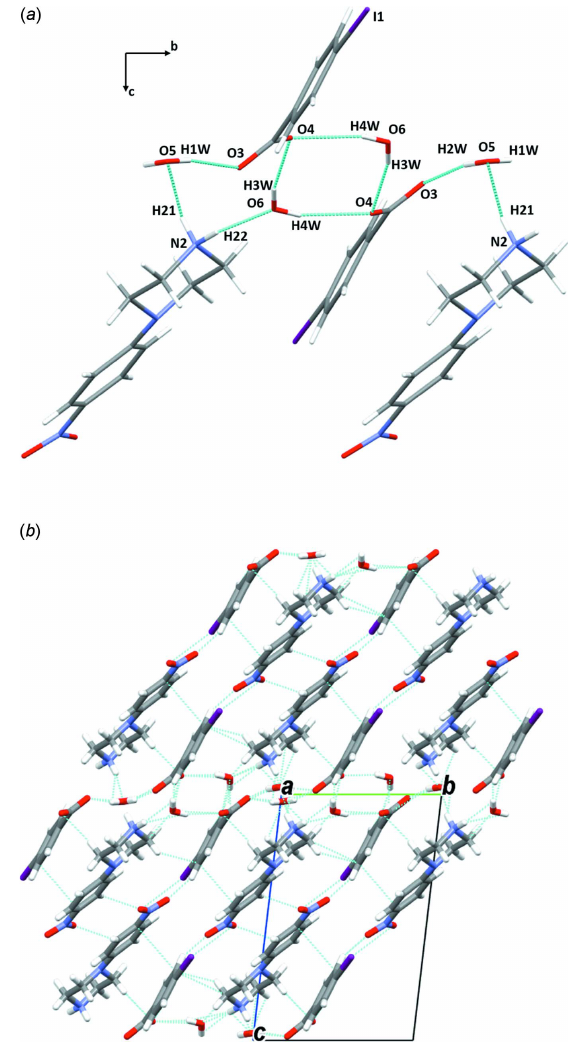
Figure 7 ( a ) A general view of the main intermolecular interactions (N—H (cid:2)(cid:2)(cid:2) O and O—H (cid:2)(cid:2)(cid:2) O) and ( b ) the molecular packing of (I) with hydrogen bonds shown as dashed